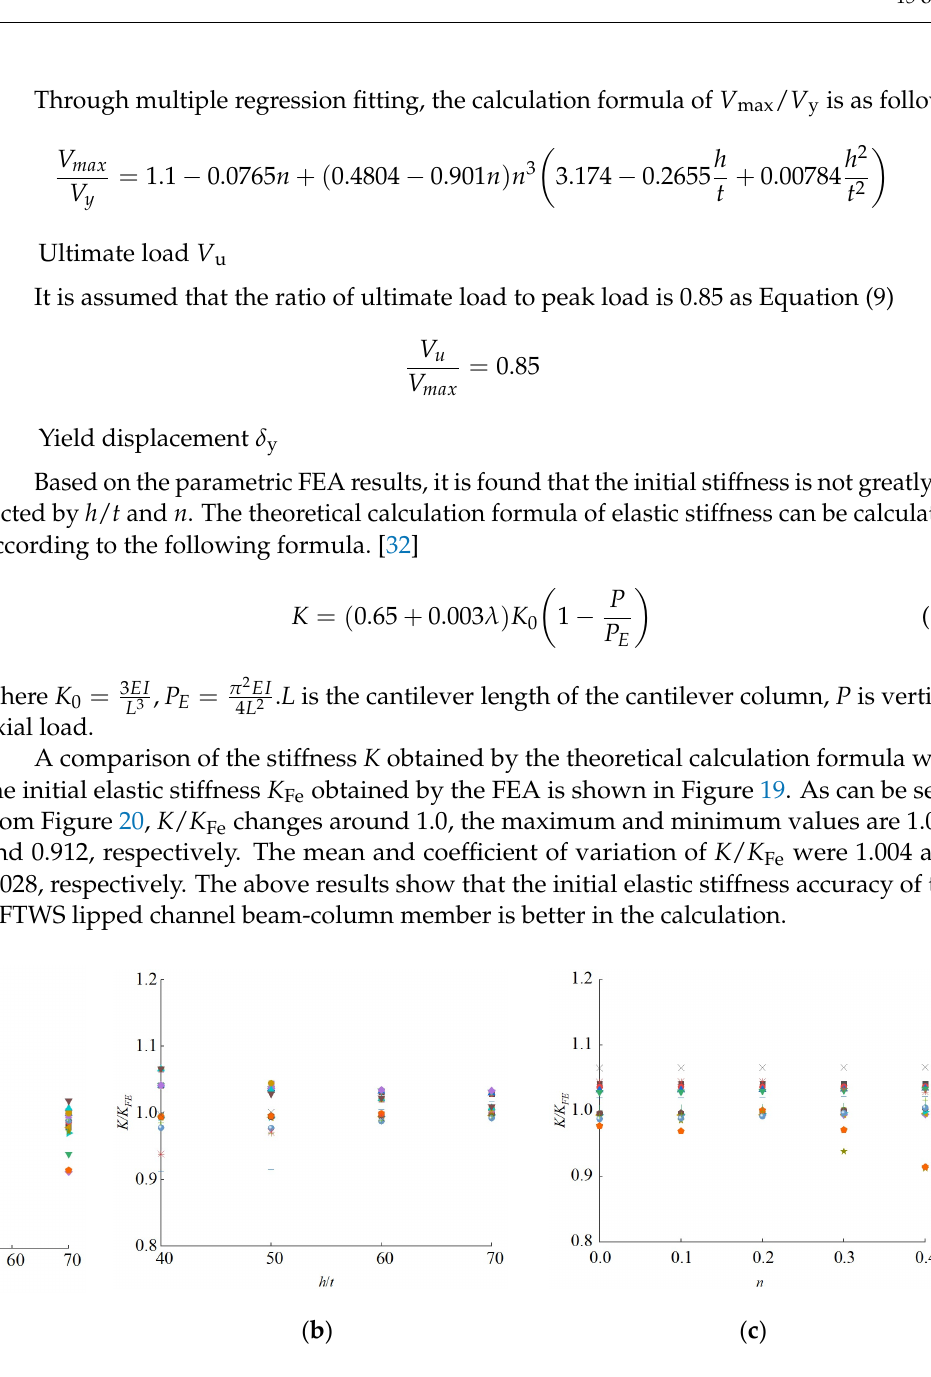
Figure 20. The initial elastic stiffness. ( a ) The effect of the λ ; ( b ) The effect of the h / t ; ( c ) The effect of n . of n